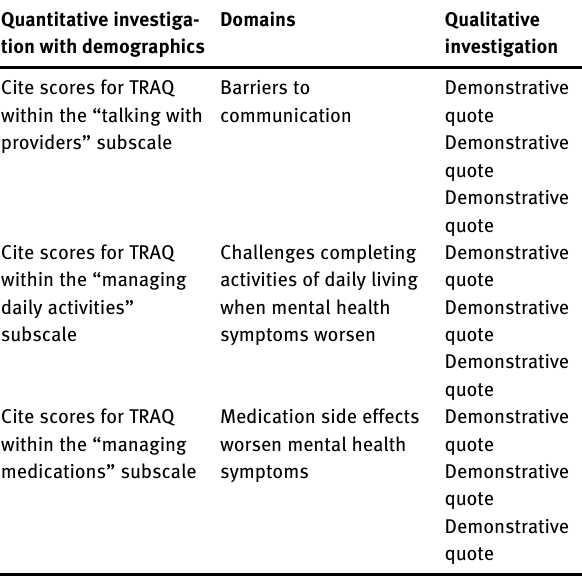
Table  : Juxtaposed fi ndings from qualitative and quantitative